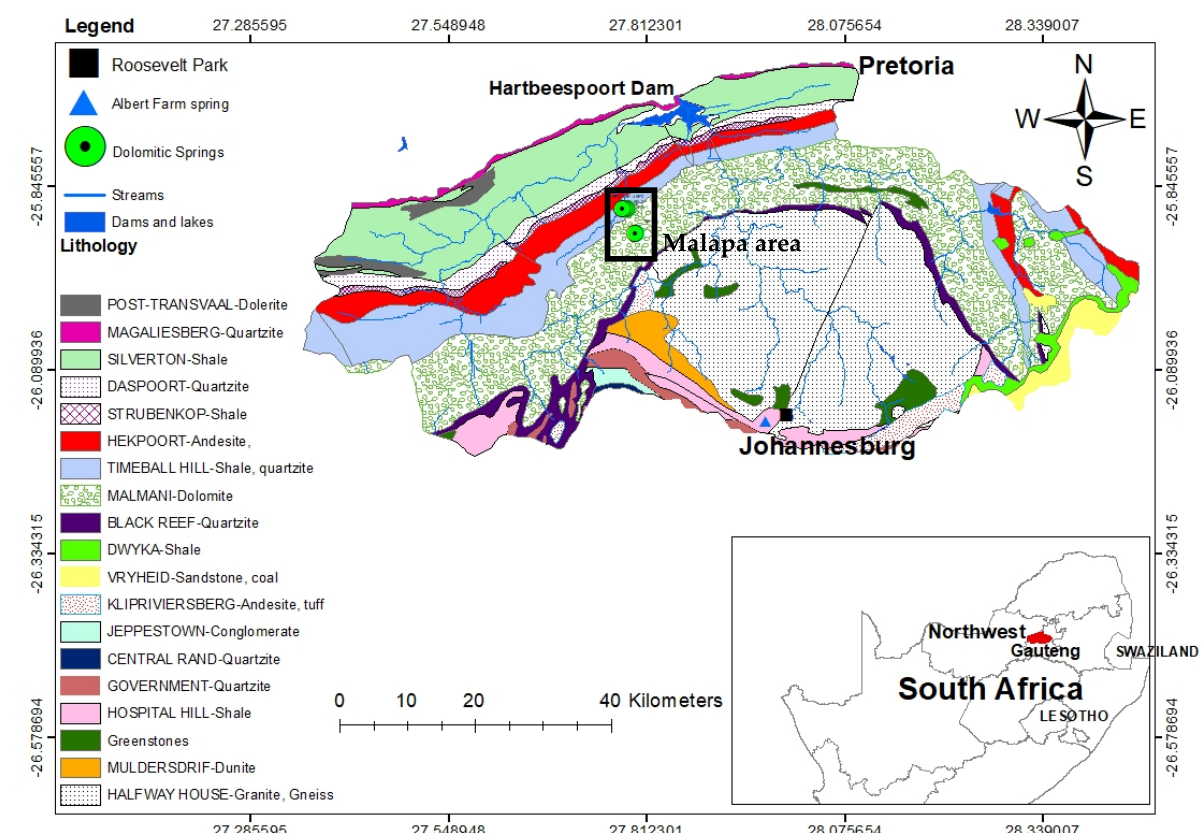
Figure 1. Location map of the study area in the Upper Crocodile River Basin and the South African map also showing the positions of Albert Farm spring and the isotope sampling points.